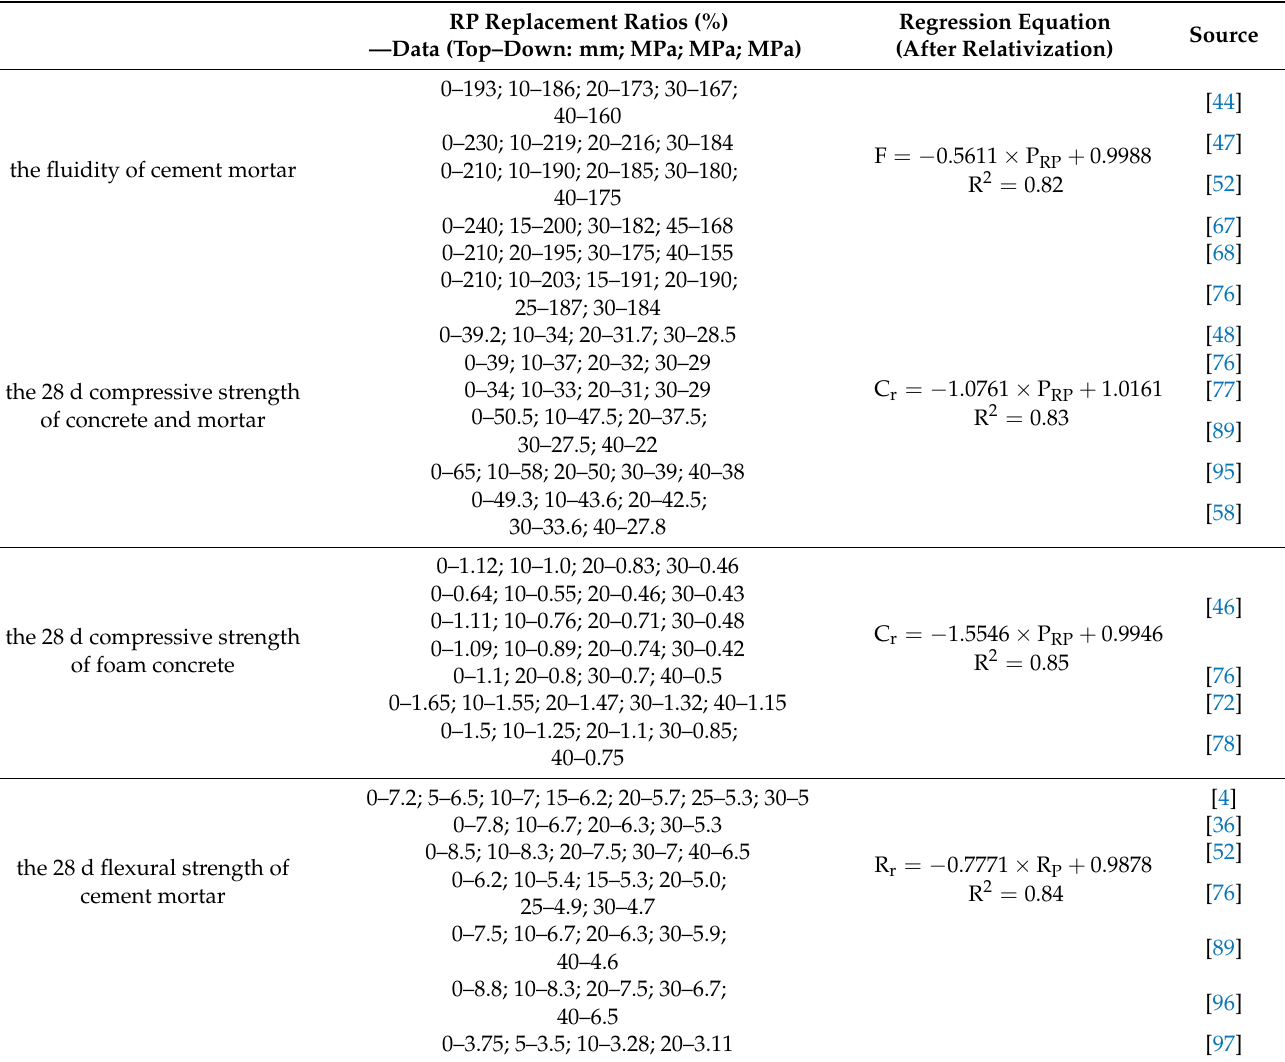
Table 3. Summary of data related to